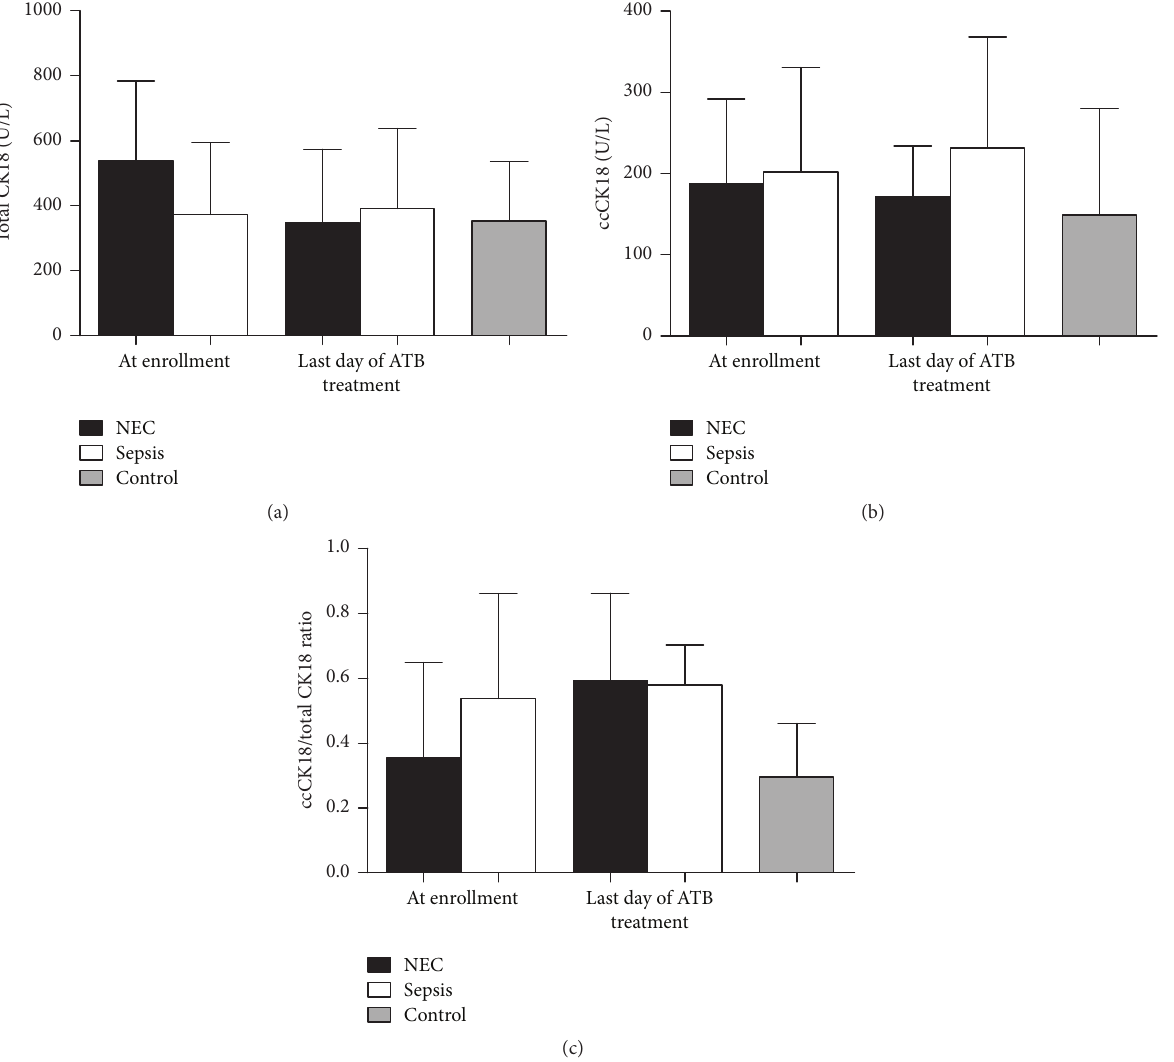
Figure 1: The analysis of cytokeratin 18 (CK18) in serum. (a) The differences between NEC and sepsis in caspase cleaved CK18 (ccCK18) ( 𝑝 = 0.7606 , Mann-Whitney test), (b) total CK18 ( 𝑝 = 0.2317 , Mann-Whitney test), and (c) ccCK18/total CK18 ratio ( 𝑝 = 0.1783 , Mann- Whitney test), at the time of enrollment and last day of antibiotic (ATB)